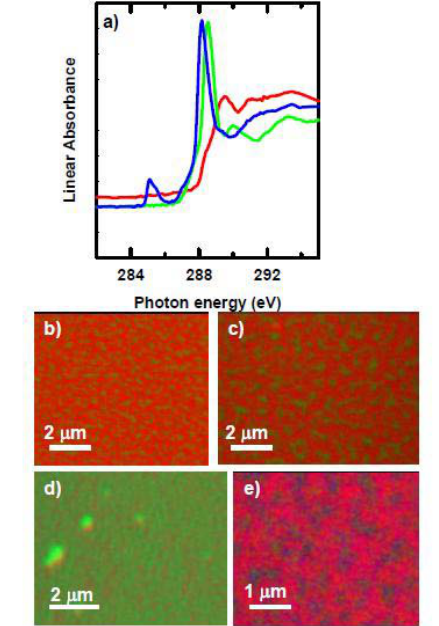
Figure 9. (a) Reference spectra of Chitosan, PMMA and HSA, (b) Chitosan/PMMA 60:40 unannealed, (c) Chitosan/PMMA annealed 18 h at 160 °C, (d) Chitosan/PMMA 40:60 annealed 18 h at 160 °C, (e) 0.05 mg/mL HSA adsorbed to annealed Chitosan/PMMA 60:40 for 20 min. Chitosan = red, PMMA = green, HSA =